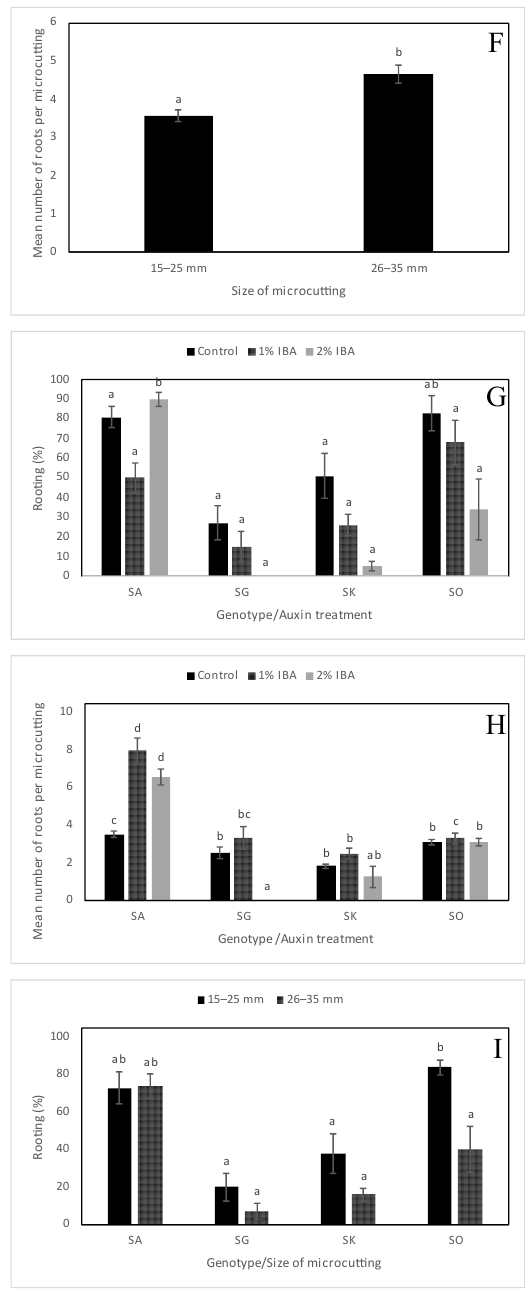
Figure 2. Rooting of microcuttings of Sorbus species treated with different concentrations of indole-3-butyric acid (IBA), applied at 0%, 1% and 2%. ( A , B ) The effect of genotype on the rooting percentage ( A ) and the mean number of roots per microcutting ( B ). ( C , D ) The effect of auxin treatment on the rooting percentage ( C ) and the mean number of roots per microcutting ( D ). ( E , F ) The effect of the size of the microcutting on the rooting percentage ( E ) and the mean number of roots per microcutting ( F ). ( G , H ) The interaction between the genotype and auxin treatment on the rooting percentage ( G ) and the mean number of roots per microcutting ( H ). ( I ) The interaction between the genotype and the size of the microcutting on the rooting percentage. Values are mean standard errors. In each graph, different letter(s) on the bars show significant differences according to Tukey’s range test ( p -value < 0.05). Sorbus × abscondita (SA), S. gemella (SG), S. × kitaibeliana (SK), S. omissa (SO).